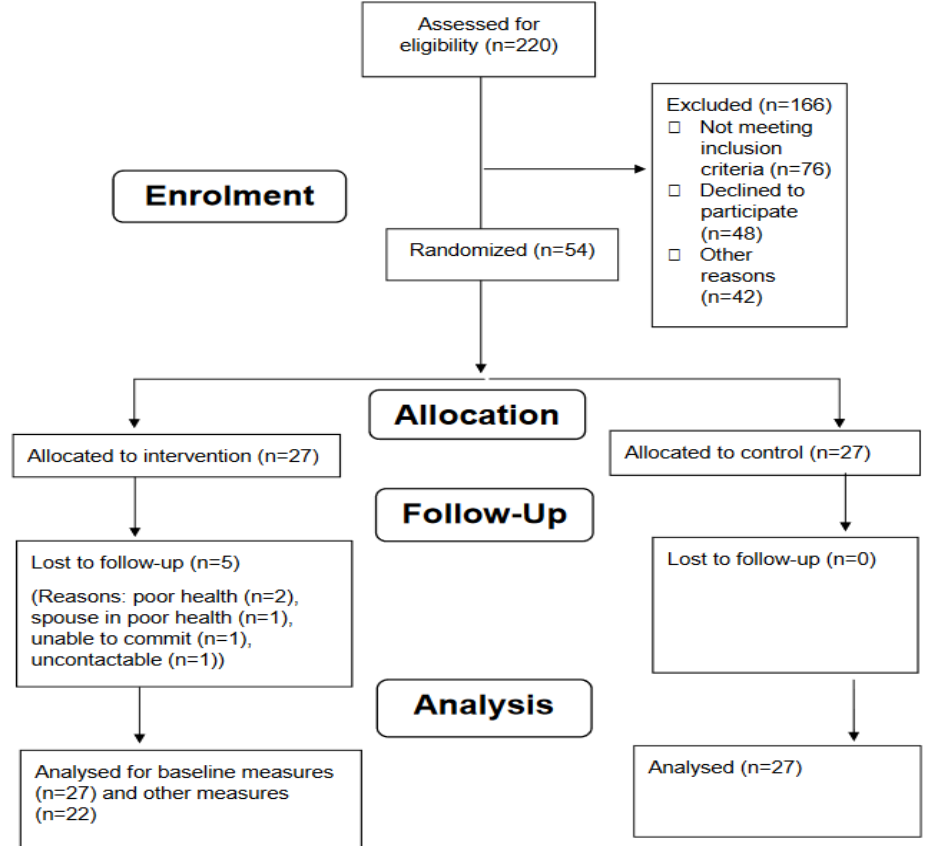
Figure 2. CONSORT Diagram Summarizing Flow of Participants’ SRBAI (automaticity) scores.